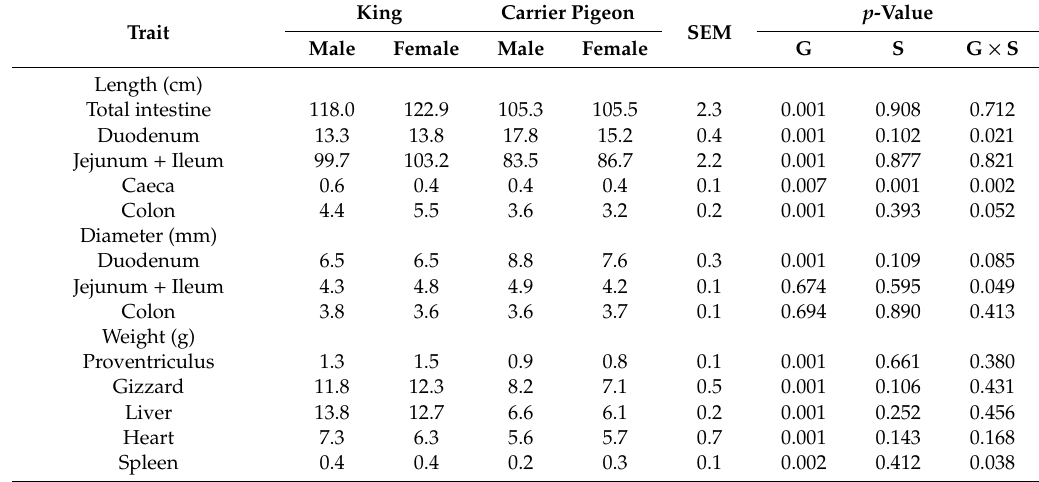
Table 7. Biometric traits of some organs in three-year-old pigeons of di ff erent